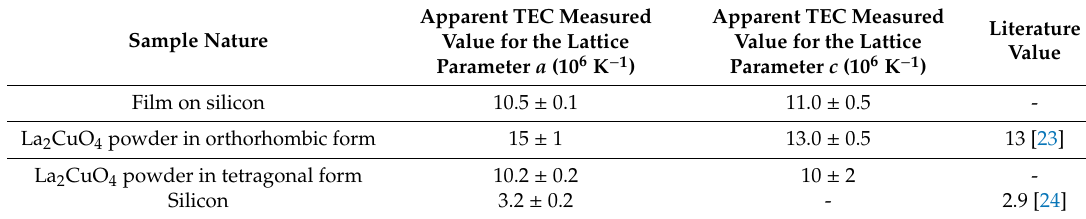
Figure 3. Evolution of the lattice constant of a thin film and a commercial powder of La 2 CuO 4 as a function of the temperature. The straight lines correspond to a fit of the experimental data. For the La 2 CuO 4 powder, the change of the slope at approx. 300 °C is due to the structural change (transformation of orthorhombic phase to a tetragonal one when the temperature increases). Table 2. Thermal expansion coefficient of silicon, commercial powder, and thin film calculated in this work and reference values